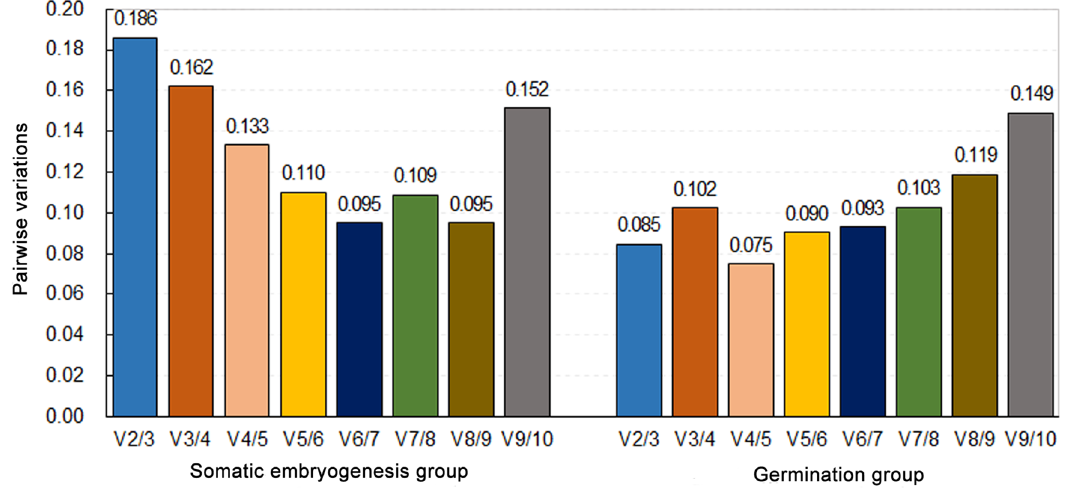
Figure 4. Pairwise variation (V) calculated by geNorm to determine the optimal number of reference genes in the somatic embryogenesis (left) and the germination (right) groups of Liriodendron hybrids. A value < 0.15 indicates that the inclusion of an additional reference gene is not required.